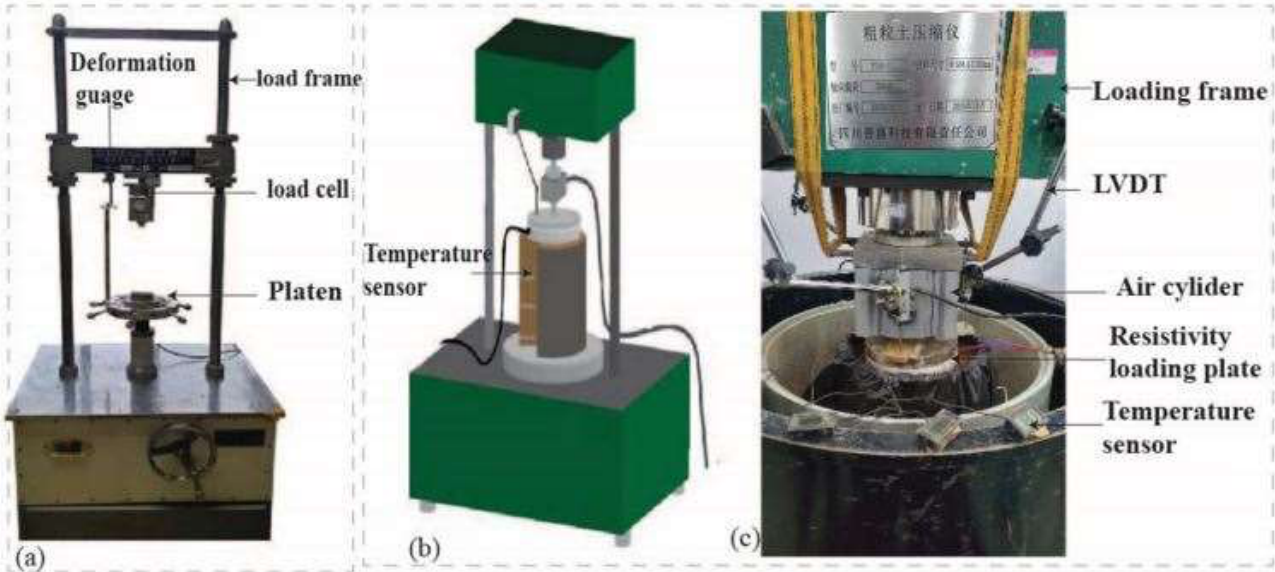
Figure 4. Experimental device. ( a ) UCS testing machine; ( b ) 3D drawing of the model test; ( c ) picture of the model test. of the model